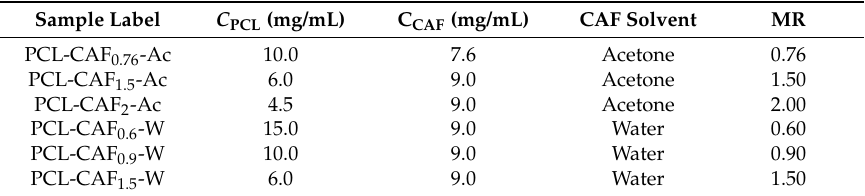
Table 1. Poly- ε -caprolactone (PCL)-caffeine nanoparticles’ formulations for which loading capacity (LC) and encapsulation efficiency (EE) were measured.